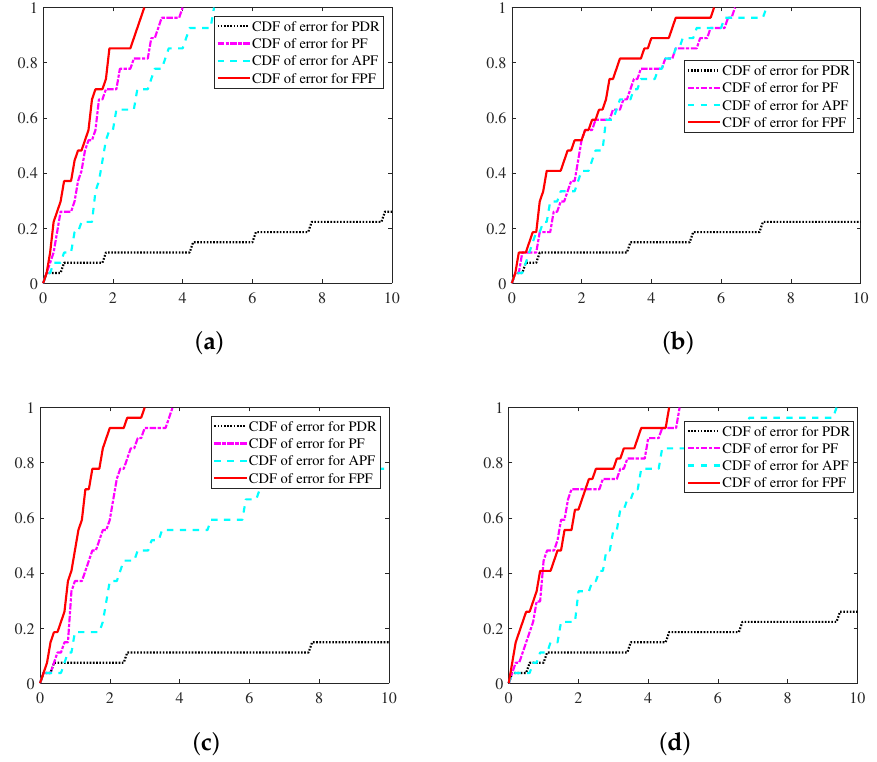
Figure 14. CDFs of errors with different modes. ( a ) CDFs of errors with calling mode. ( b ) CDFs of errors with dangling mode. ( c ) CDFs of errors with handheld mode. ( d ) CDFs of errors with pocketed